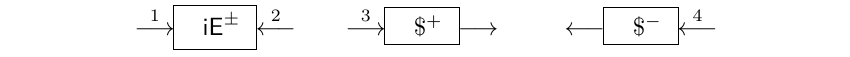
Algorithm B 1 outputs two lists of sizes at most ‘ 1 ≤ q e and ‘ 2 ≤ q ; B 2 outputs lists of sizes at most ‘ 1 ≤ q d and ‘ 2 ≤ q ; B 3 ’s lists are of sizes at most ‘ 1 , ‘ 2 ≤ q e ; B 4 ’s lists are of sizes at most ‘ 1 , ‘ 2 ≤ q d , and B 5 ’s lists of sizes at most ‘ 1 ≤ q e and ‘ 2 ≤ q d